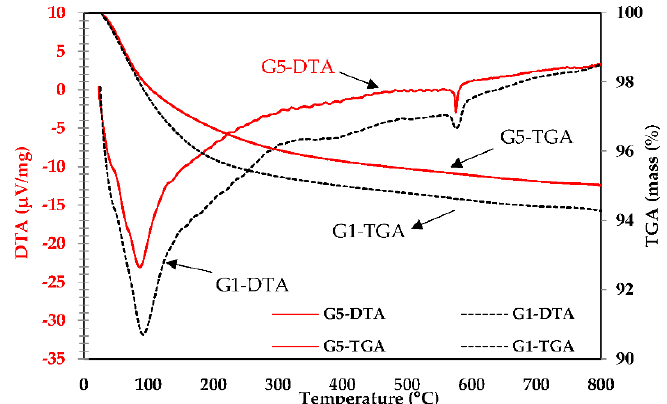
Figure 15. Weight loss and derivative thermogravimetric (DTA) curves of UHPGC mixtures.